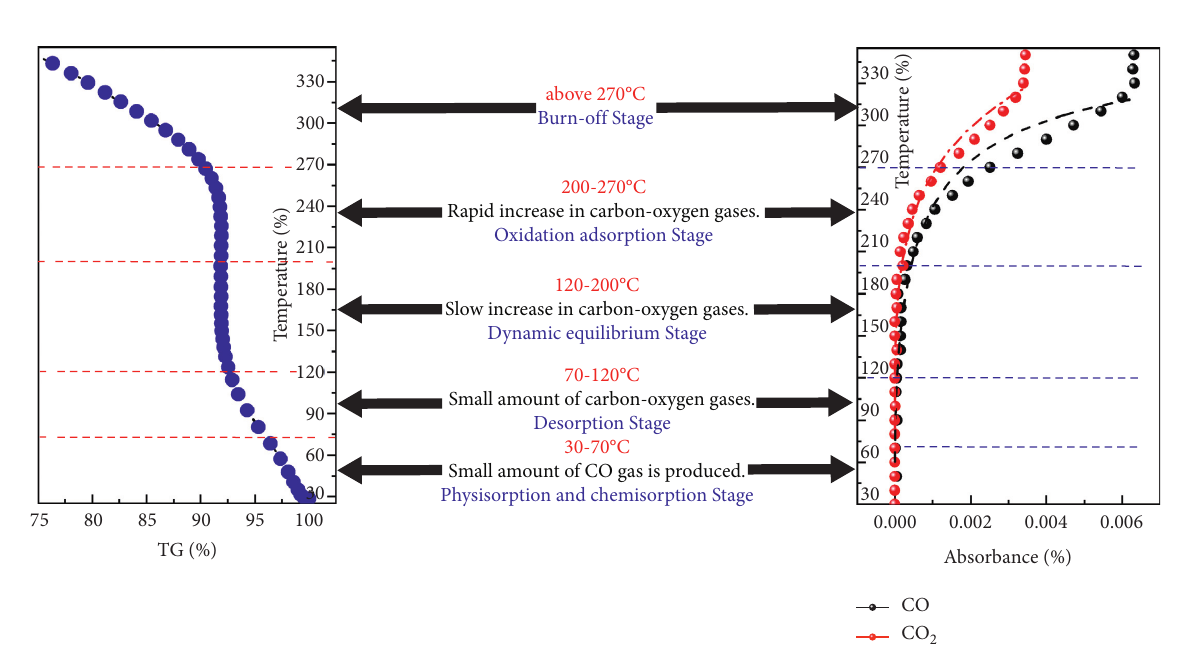
Figure 8: Stage characteristics of carbon oxides at low-temperature coal